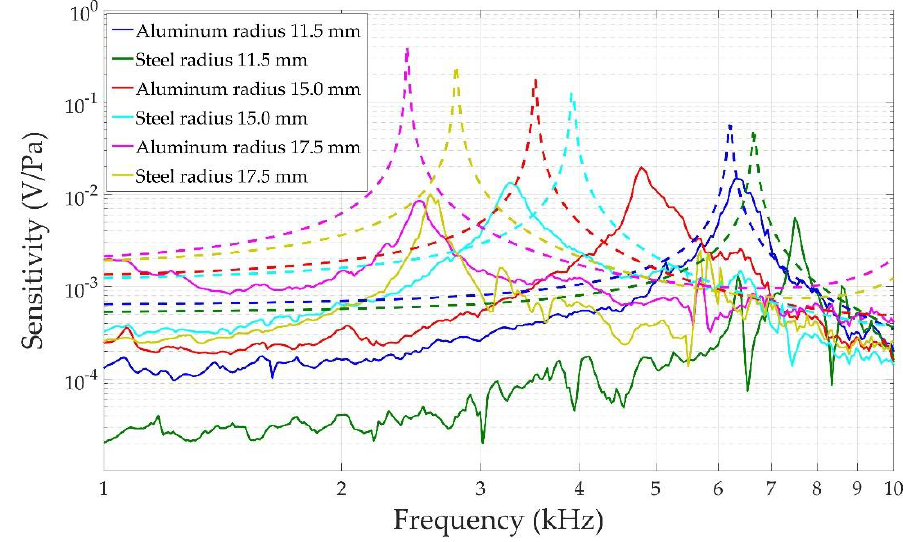
Figure 8. Measured sensitivity (solid lines) and simulated sensitivity (dashed lines) of the six sensors.